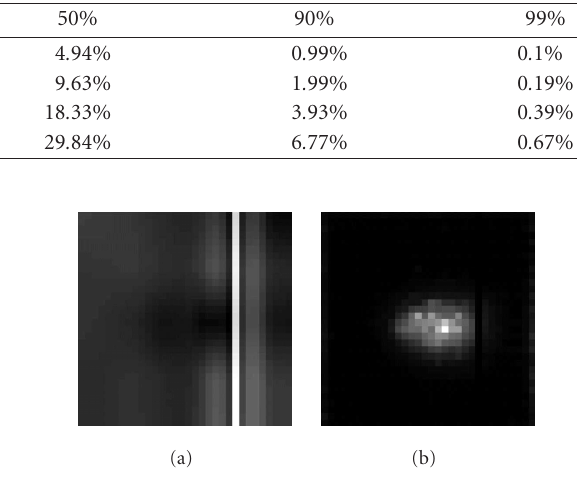
Figure 5: Resulted NGC 1808 image after (a) JPEG 2000 compres- sion (EBCOT method) for a compression ratio of 6 and (b) on- board processing for CR =